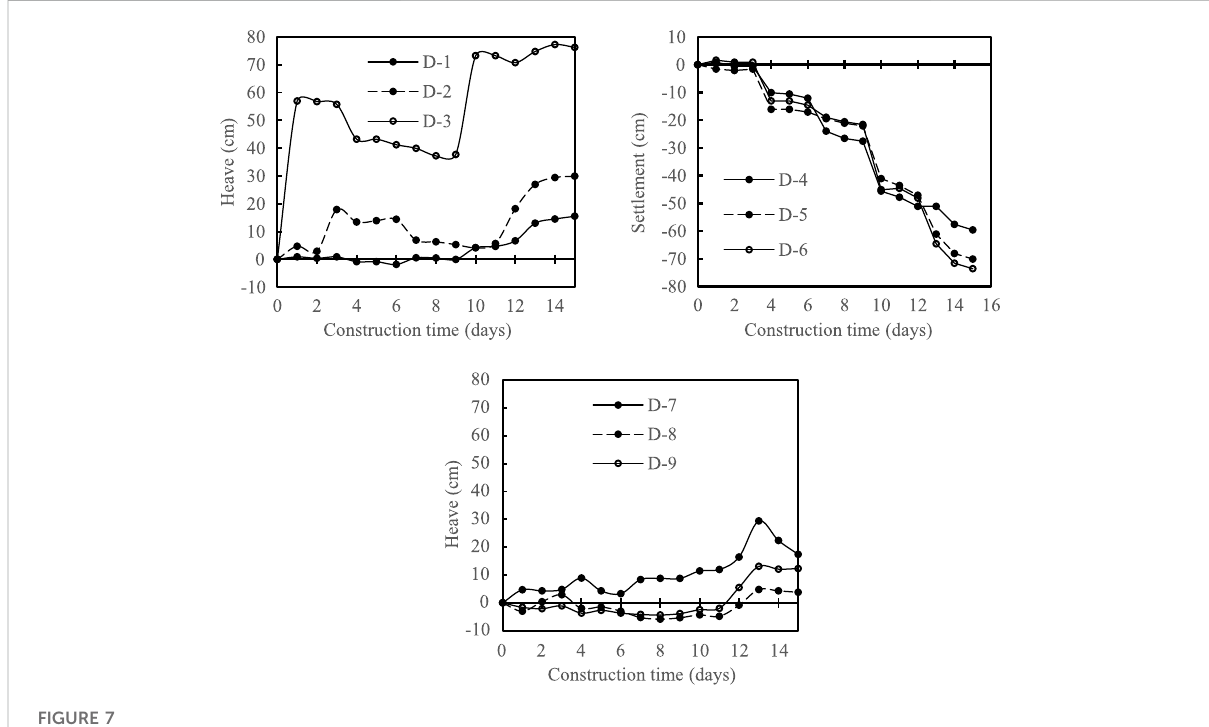
FIGURE 7 Settlement of the embankment versus construction time at different loading stages.